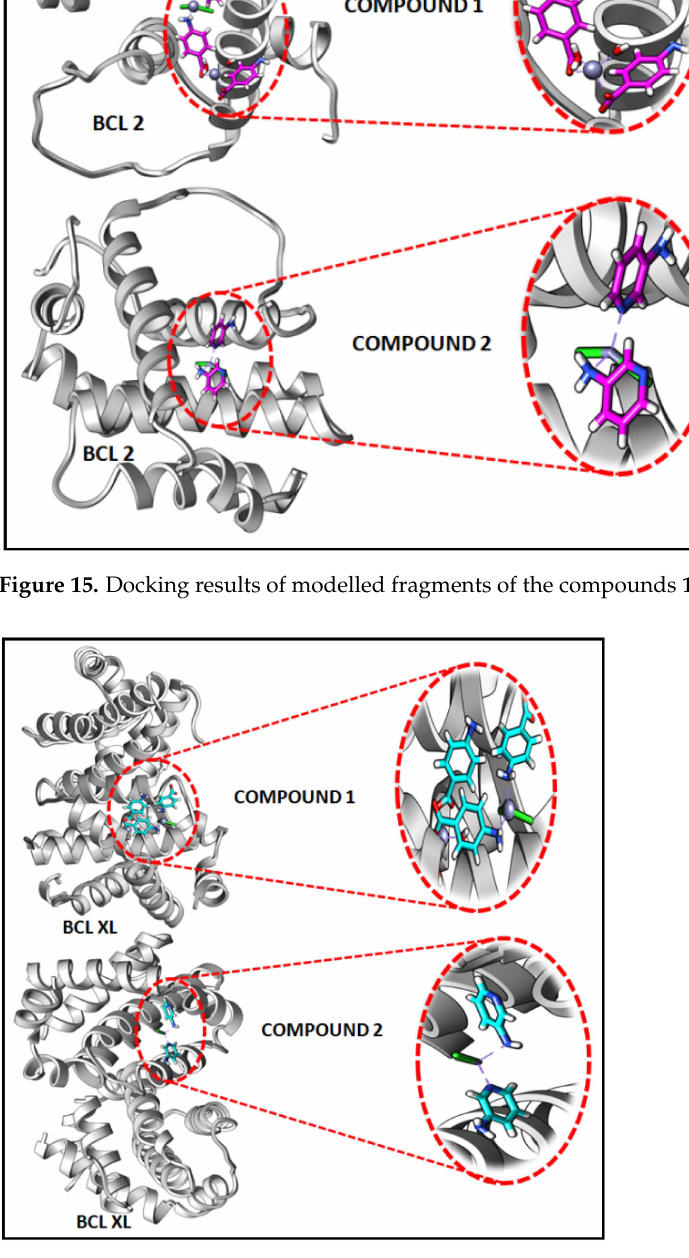
Figure 16. Docking results of modelled fragments of the compounds 1 and 2 with BCL-XL